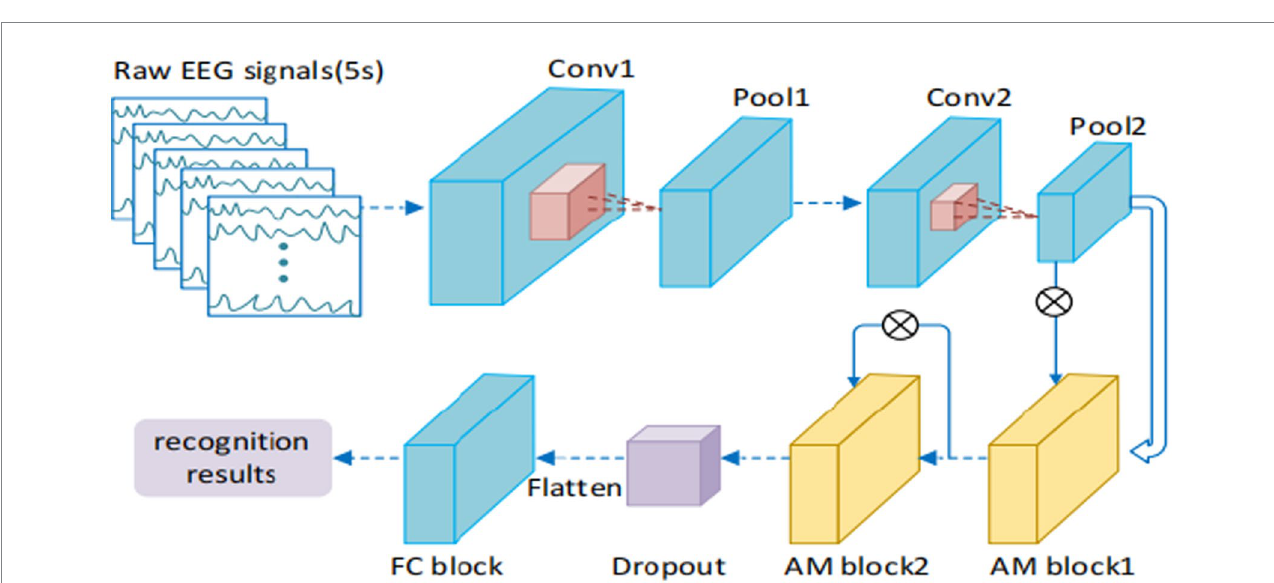
FIGURE 10 The flow of the 3DCANN algorithm (Liu et al.,2021). Reproduced with permission from IEEE. Licence Number: